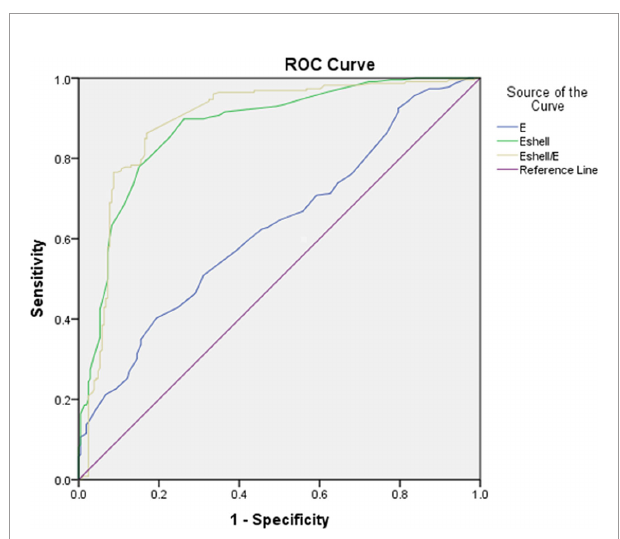
FIGURE 5 | Receiver operating characteristic curves of E , E shell , and E shell / E to analyze diagnostic performance (AUC of E = 0.629; AUC of E shell = 0.876; AUC of E shell / E =